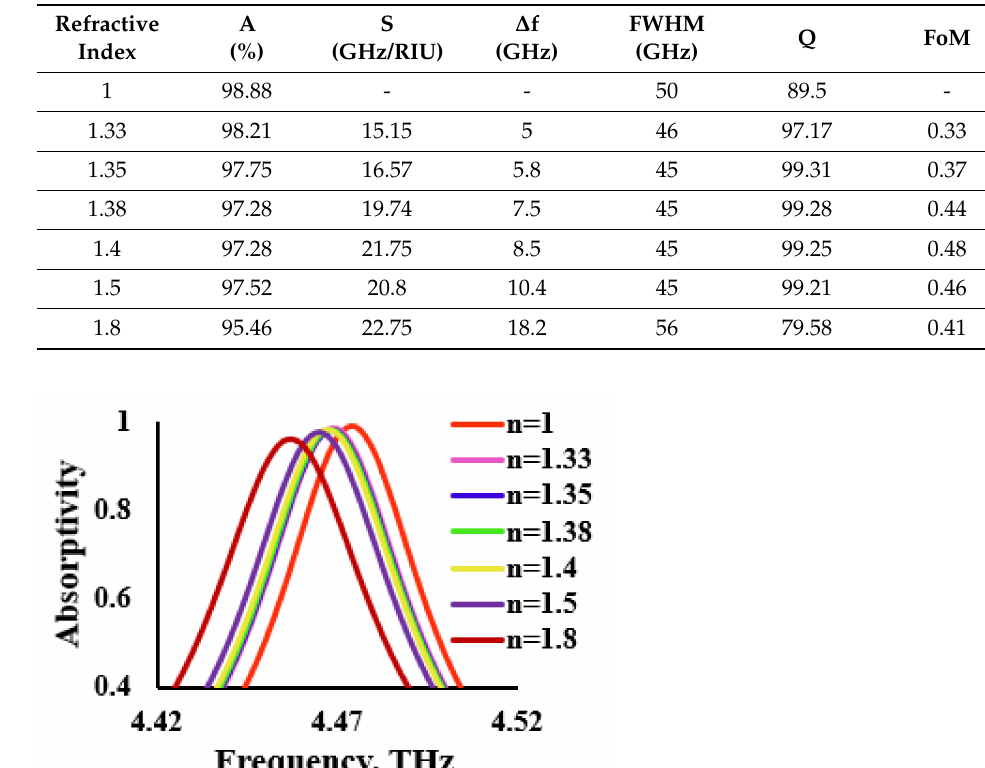
Table 2. Absorption characteristics of various refractive indices.